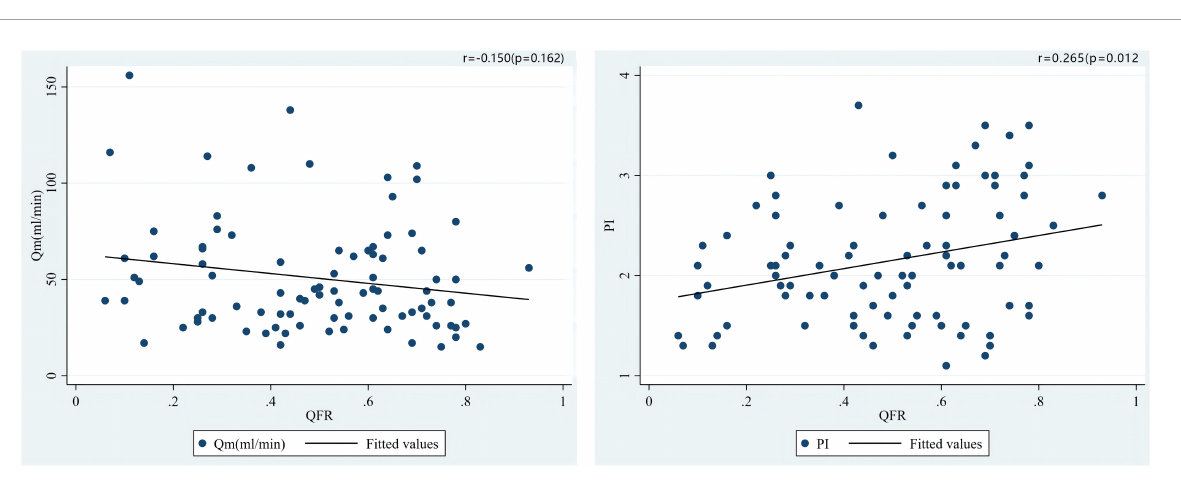
FIGURE4 Correlations of the preoperative QFR of the LAD and the parameters of intraoperative TTFM of the in situ LITA graft to the LAD, including Qm and PI.